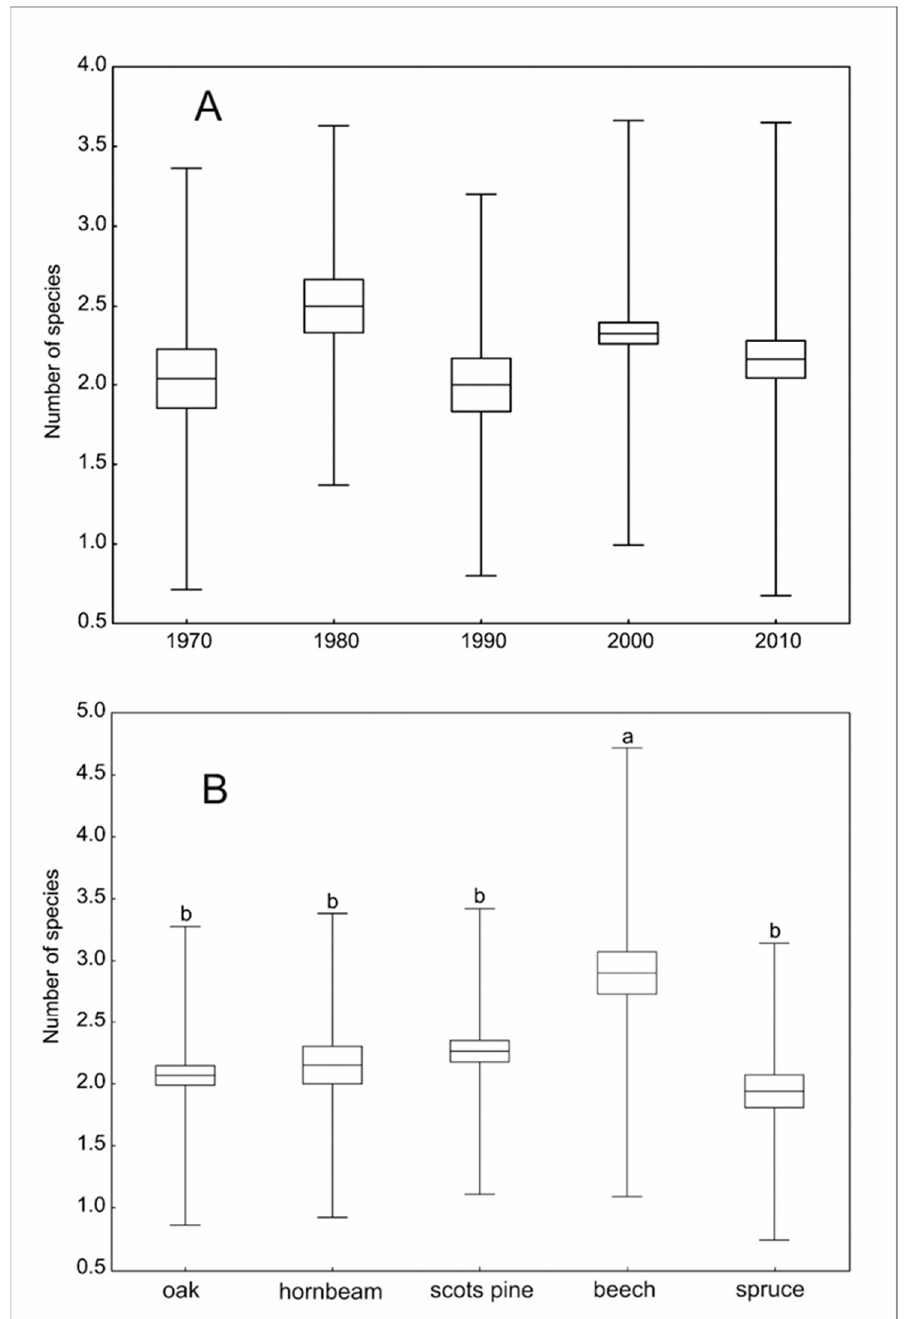
Figure 5. Average number of Uropodina species: ( A ) in relation to research period, and ( B ) in relation to tree species, box—standard error, whiskers—standard deviation. Letters a, b, c—statistically significant differences between species at the level of p < 0.05.